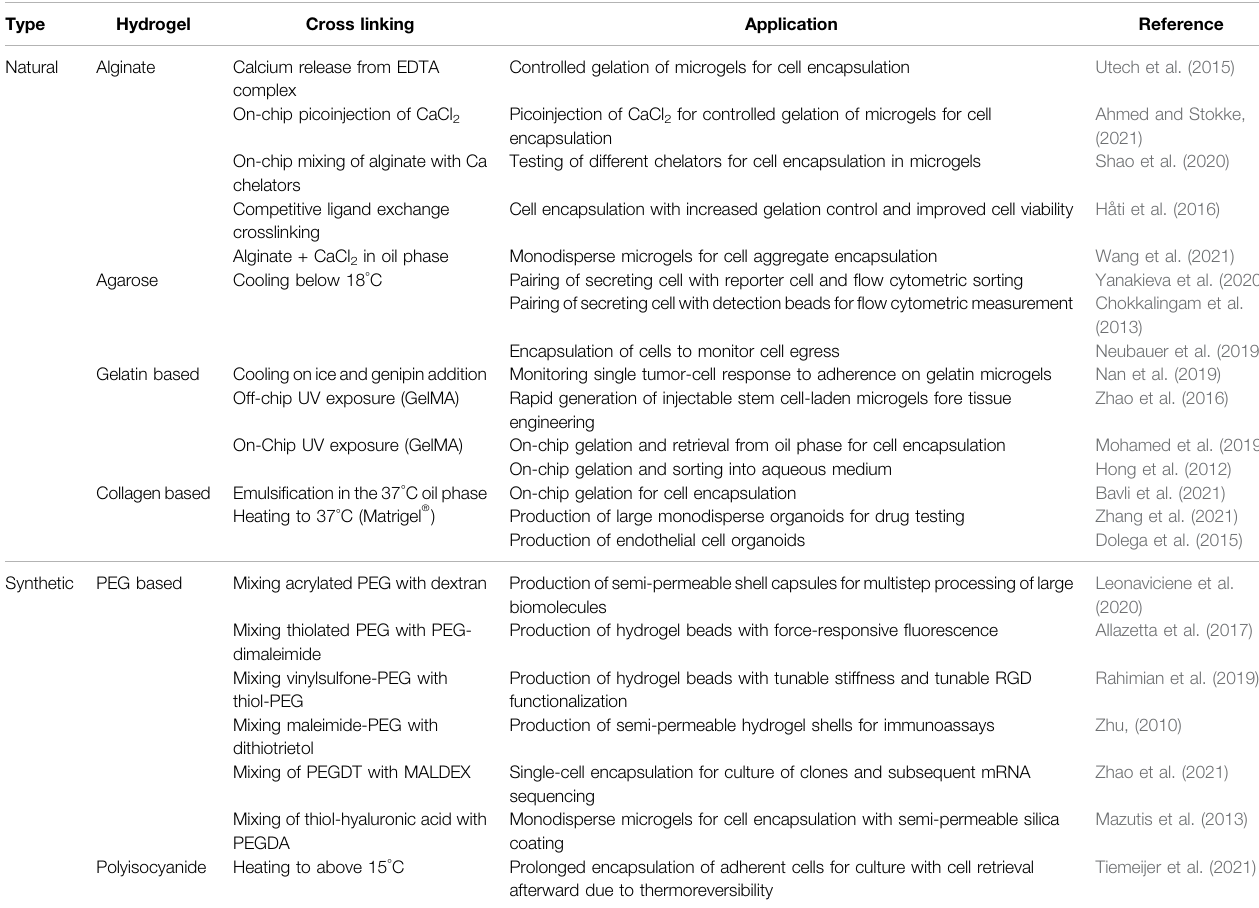
TABLE 1 | List of recently published research using various types of natural and synthetic hydrogels for innovative single-cell microgel